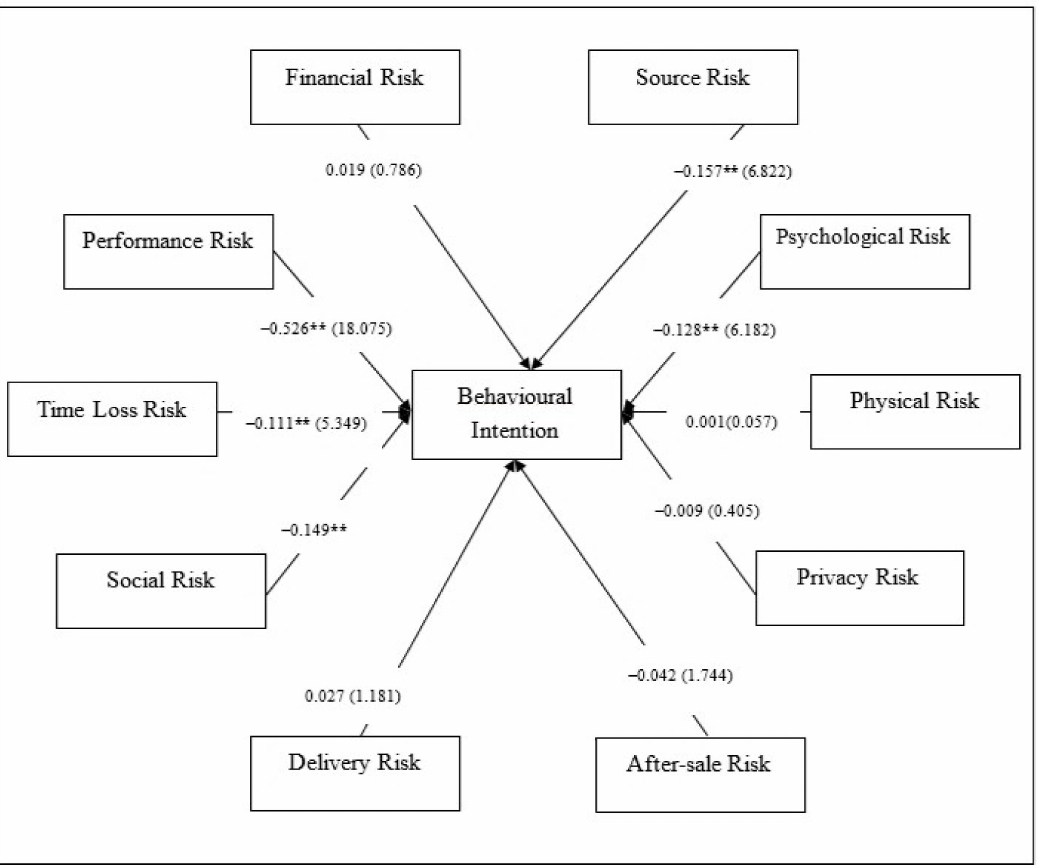
Figure 2. Structural Equation Modelling (SEM) Analysis of the Research Model. ** : p -value <